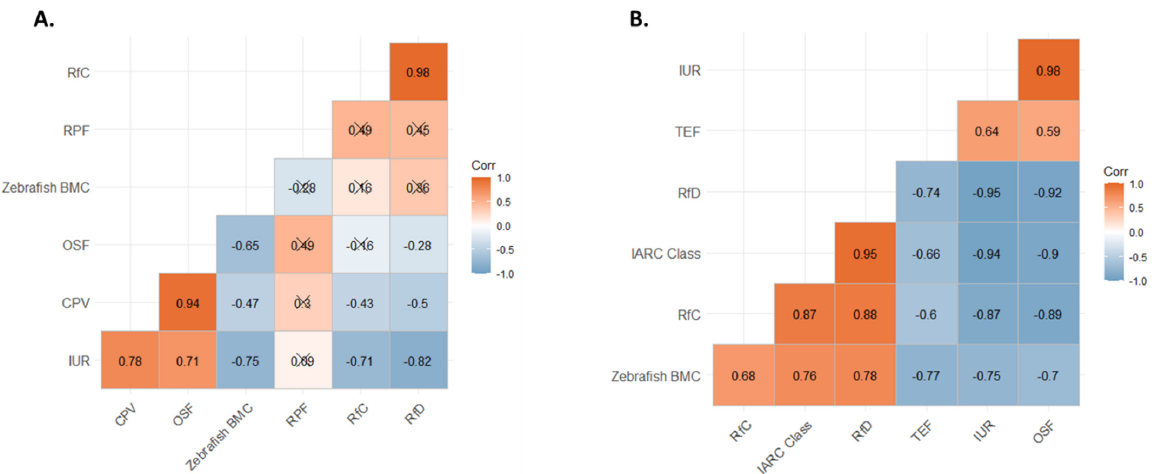
Figure 3. Correlations of Toxicity Metrics. ( A ) Correlation matrix of rankings for toxicity metrics used for Toxicity Mix. ( B ) Correlation matrix of toxicity metric rankings for Weighted-Toxicity Mix. Each square is labeled with correlation coefficient. Anything with an X was not significant. Significance cut-off was p < 0.05 using Pearson correlation coefficient. Correlations were conducted for each chemical only for complete observations.